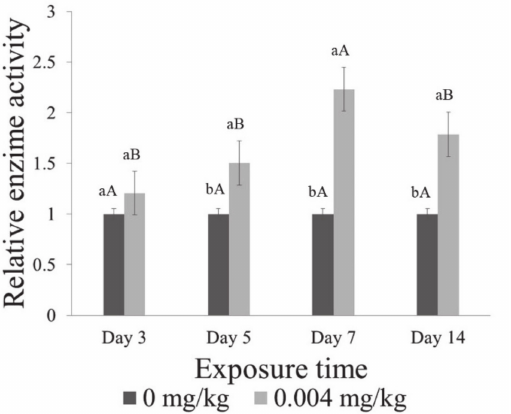
Figure 11. Relative enzyme activity (measured with respect to control), during 14 days of exposure. Lowercase letters indicate the statistically significant difference ( p < 0.05) for each day of exposure and uppercase letters indicate the statistically significant difference ( p < 0.05) between